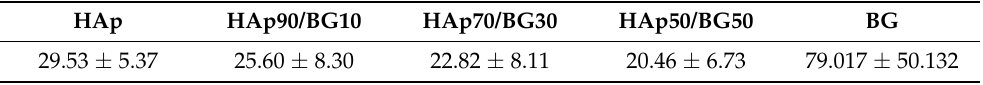
Table 2. Particle size obtained from TEM images by Image J